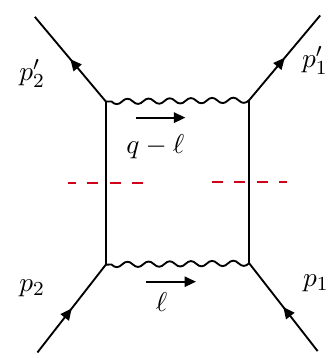
Figure 2. The two-particle cut